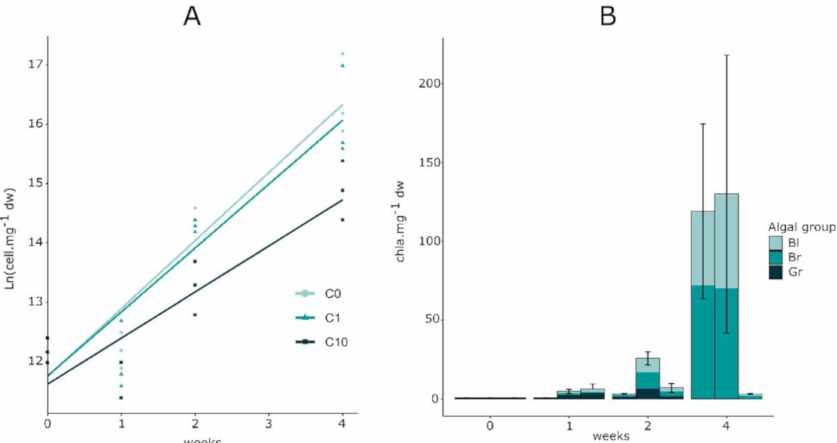
Figure 2. ( A ) Diatom growth measured in the biofilm of controls (C0 = 0.2 ± 0.1 nM) and Zr exposures (C1 = 0.5 ± 0.3 nM and C10 = 2.9 ± 0.3 nM). A two-way ANCOVA was performed to detect significant di ff erences between exposure times ( p < 0.05; n = 3). ( B ) Blue (Bl), brown (Br), and green (Gr) chlorophyll fluorescence from biofilm autotrophs measured in control and Zr exposures (C1 and C10). Values are